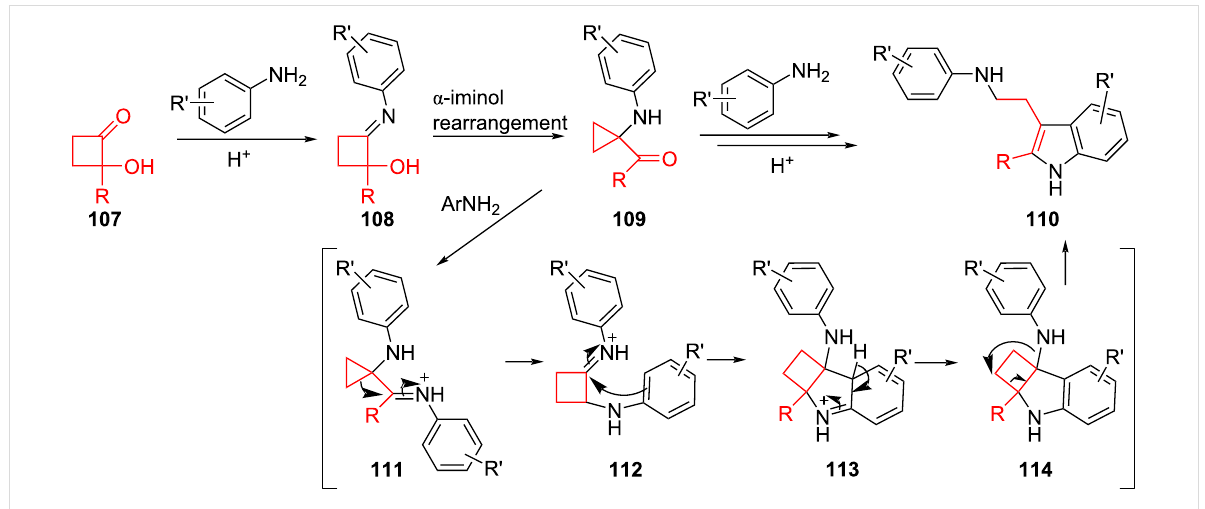
Figure 20: Synthesis of tryptamines 110 via a ring-contracting α‑ iminol rearrangement. A mechanism for the final step has been proposed to occur through cyclobutyl intermediates 112 and 114 (some steps have been added/modified from the original source).